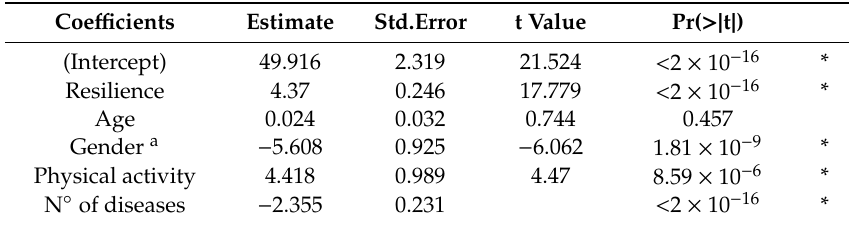
Table 5. Regression models with self-reported psychological well-being (SPWB) as the dependent variable: Model 2a (physical activity).